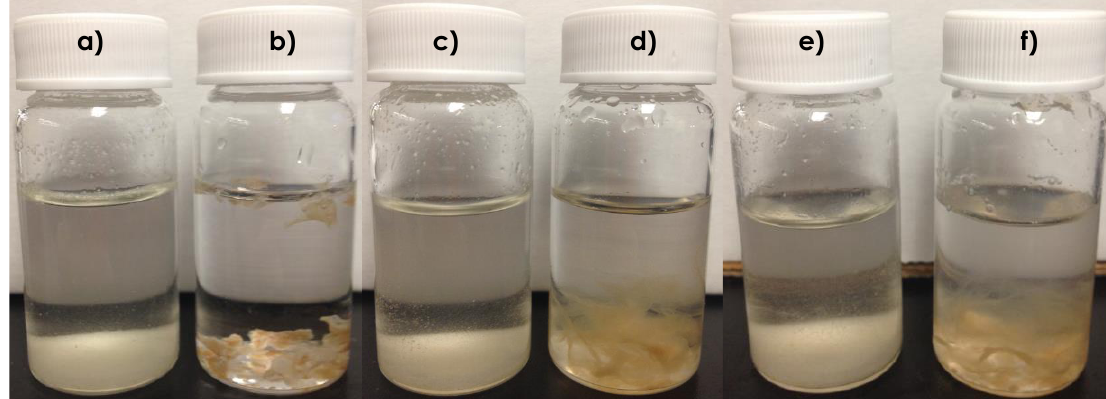
Figure 5. CO 2 switchability tests: ( a ) chitosan in water (pH = 8.74); ( b ) CTS– g –GMA–PDEAMEA in water (pH = 7.18; ( c ) chitosan after 1 h of CO 2 bubbling (pH = 4.96); ( d ) CTS– g –GMA–PDEAEMA after 1 h of CO 2 bubbling (pH = 5.42); ( e ) chitosan (pH = 8.12) after 1 h of CO 2 bubbling (pH = 5.42), followed by 1 h of air bubbling; ( f ) CTS– g –GMA–PDEAMEA (pH = 7.32) after 1 h of CO 2 bubbling (pH = 5.42), followed by 1 h of air bubbling.